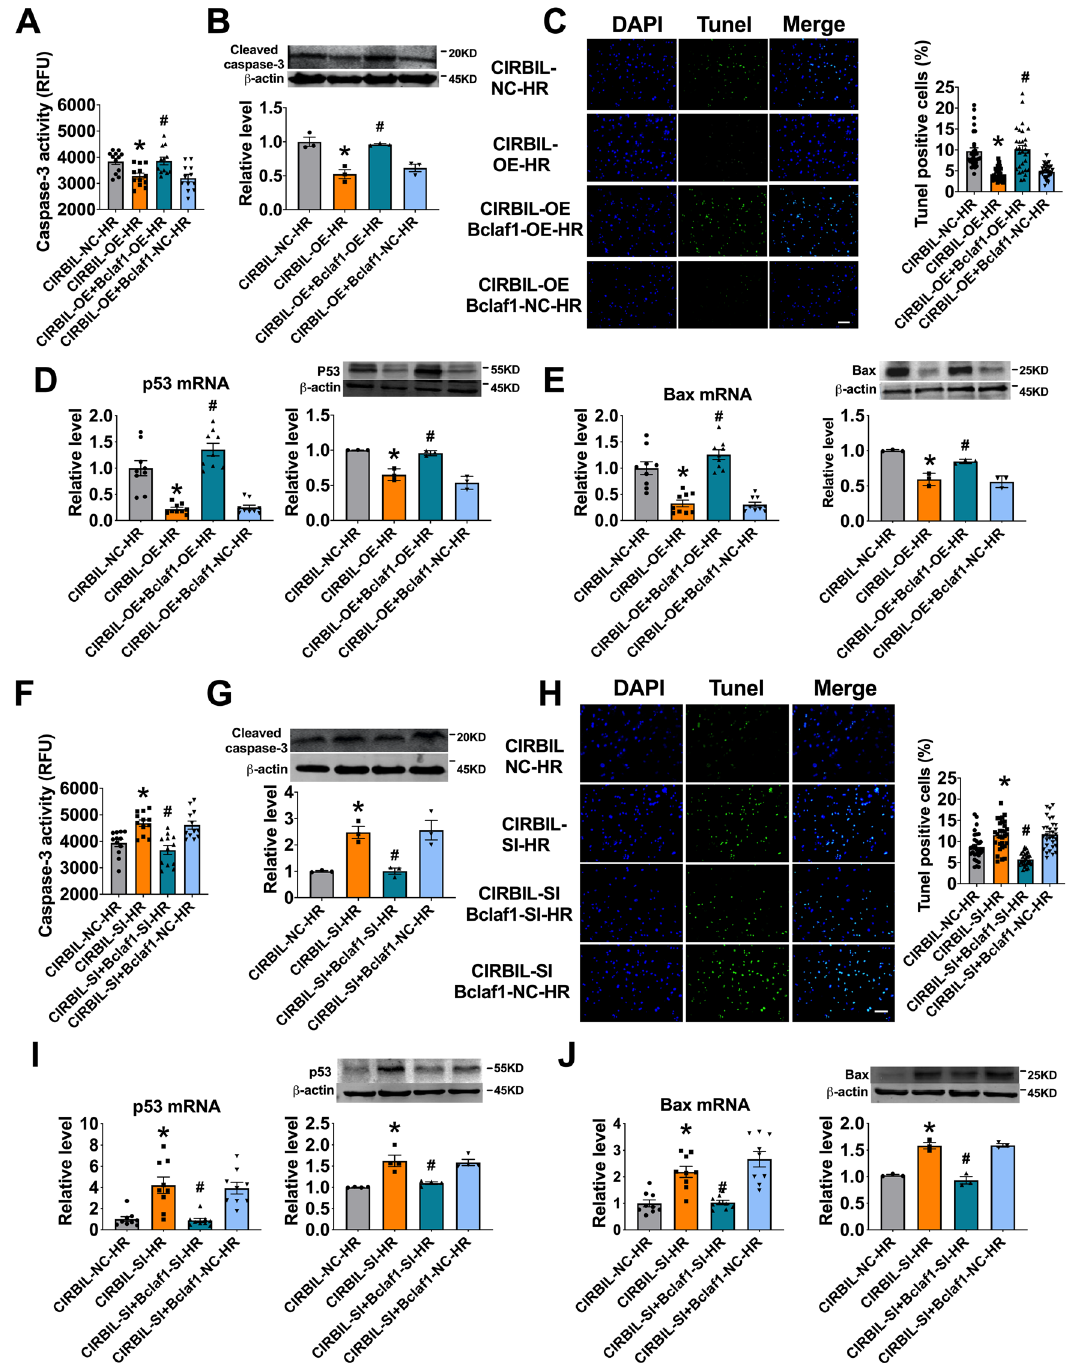
Generation of mouse line with cardiomyocyte-speci fi c Bclaf1 overexpression . To analyze the function of Bclaf1 in cardiomyocytes in vivo, cardiomyocyte-speci fi c Bclaf1 transgenic overexpression mice were generated. A transgene containing Bclaf1 was cloned downstream of the α -MHC promoter. A fragment containing the promoter region and transgene sequence was agarose gel puri fi ed and micro- injected into the pronucleus of one-cell mouse embryos of C57BL/6 mice at Cyagen Biosciences Inc. (Guangzhou, China). Transgenic mice were identi fi ed by con- ventional PCR of genomic DNA from mouse tissue, and the relevant primer pair used for verifying the transgenic mice is: forward 5 ′ -AGAGCCA- TAGGCTACGGTGTA-3 ′ , reverse 5 ′ -TCTGTACCCATAAGGTCGTCTC-3 ′ . Control mice were C57BL/6 mice or negative littermate mice. The mice used for our experiments were all male at an age of 8 weeks. Construction of Bclaf1 knockdown virus . The recombinant serum type 9 adeno- associated virus system (AAV9) was used to construct